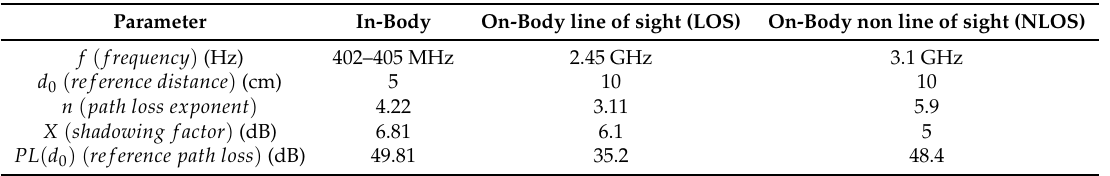
Table 1. Channel model